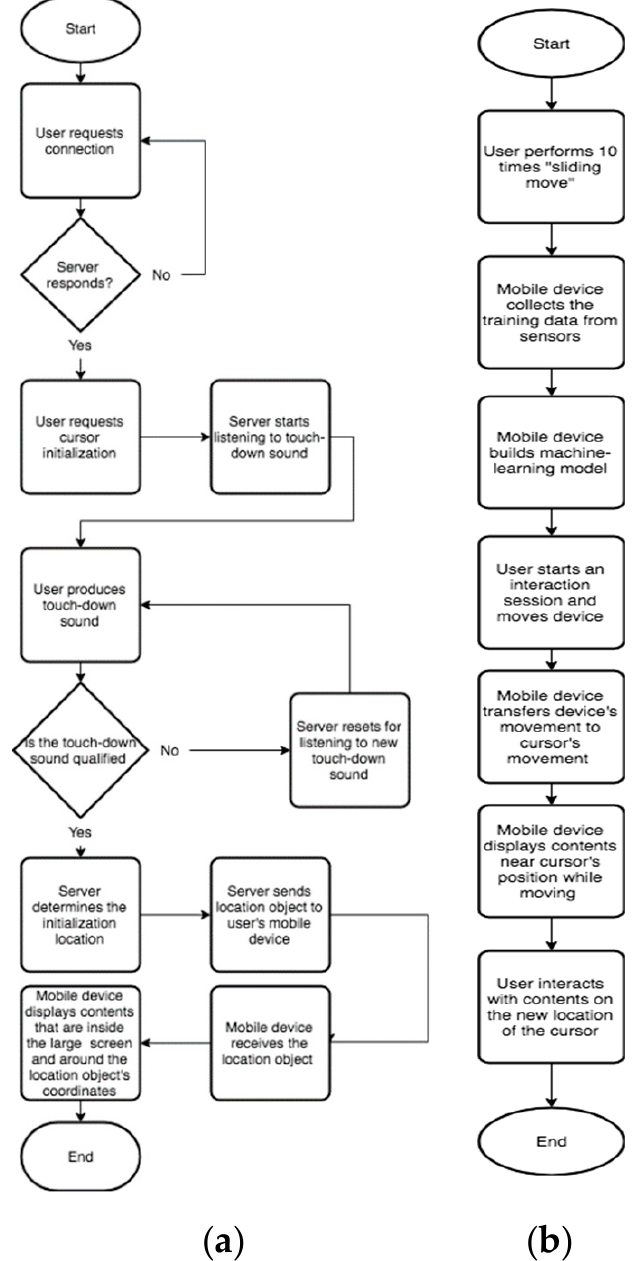
Figure 2. The flowcharts of the cursor initialization and estimation process. ( a ) Cursor initialization; ( b ) cursor motion detection.